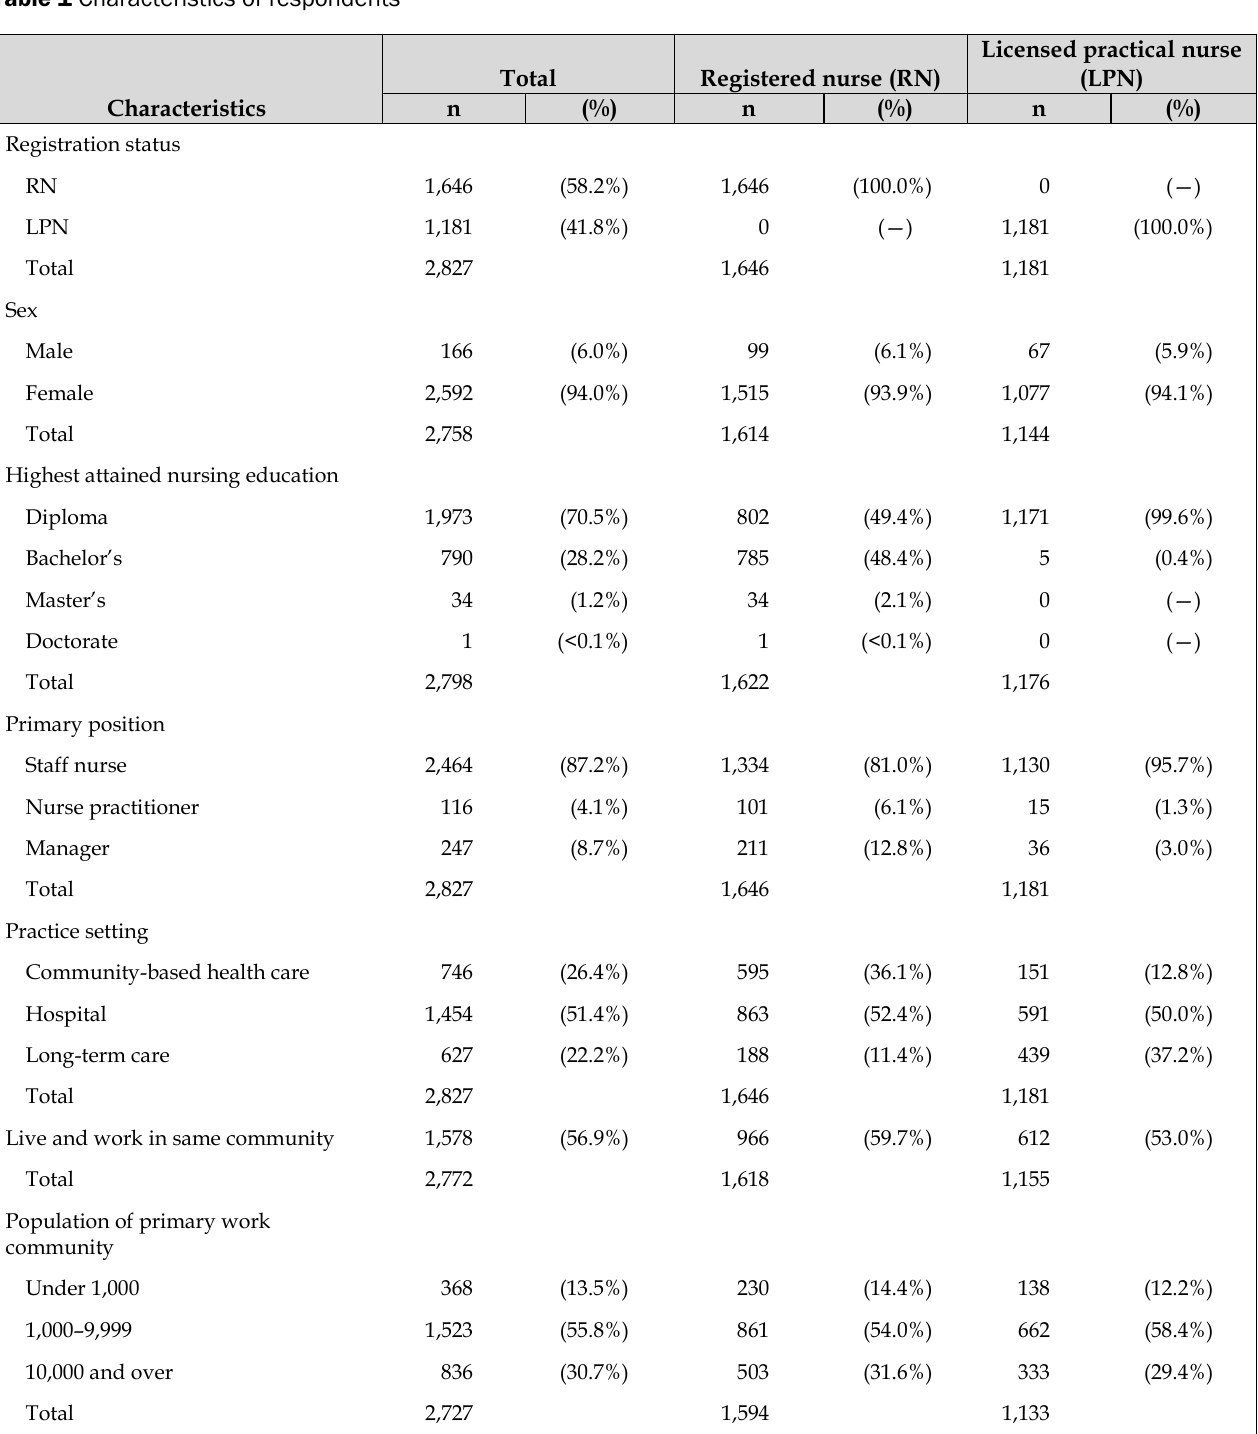
Table 1 Characteristics of